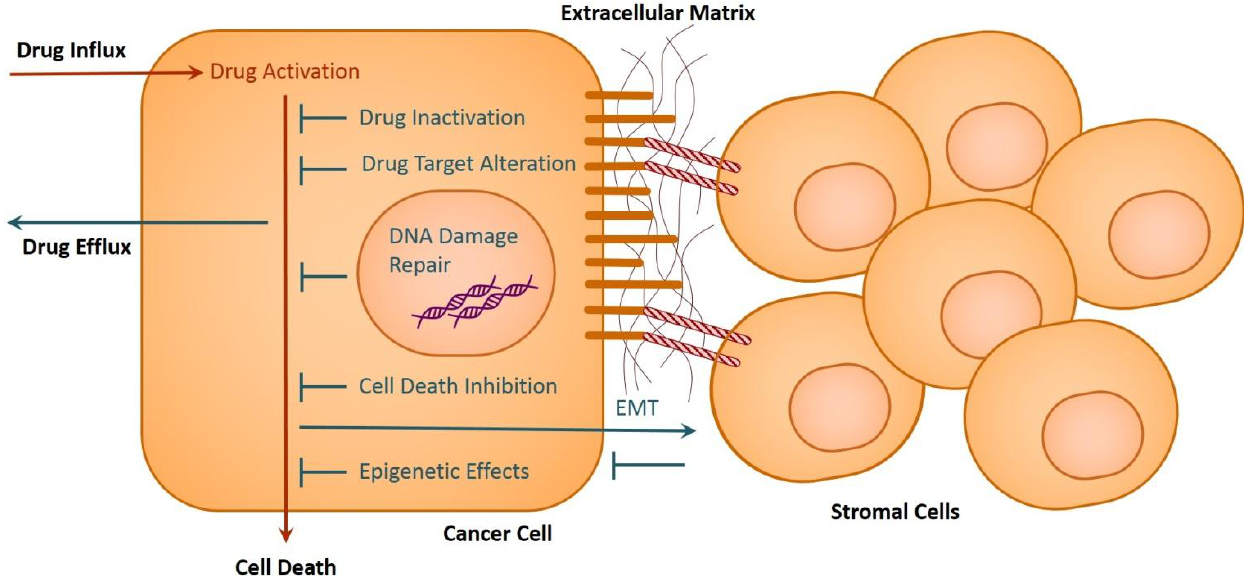
Figure 2. Depiction of the primary mechanisms that enable cancer cells to become drug resistant. These include drug inactivation, alteration of drug targets, drug efflux, DNA damage repair, inhibition of cell death, EMT, and epigenetic effects. In the case of EMT, stromal cells assist in this process and signal for improved drug resistance in cancer cells. Cell adhesion molecules on stromal cells and extracellular matrix proteins attach to the cell adhesion molecules on cancer cells. Stromal cells and cancer cells also secrete factors that regulate EMT. The depiction displays a simplified example of these cell